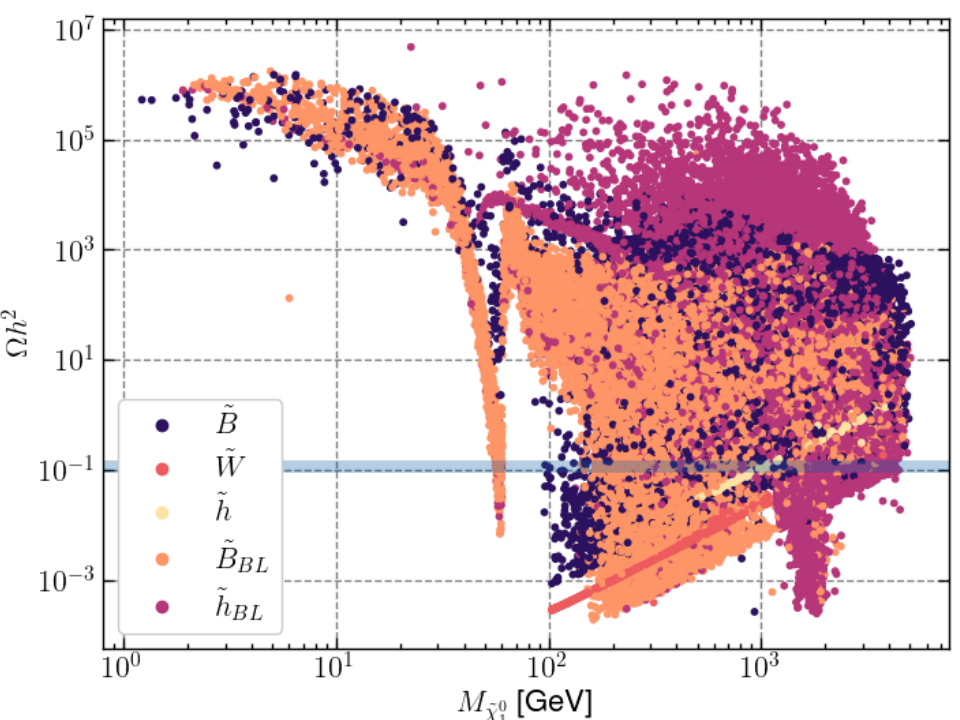
Figure 1: The relic density of the lightest neutralino as a function of its mass. The dominant component of the neutralino is colour coded as (cid:101) B (blue), (cid:102) W (red), (cid:101) h (yel- low), (cid:101) B (orange), and (cid:101) h (purple). The observed relic density of the Planck col- BL BL laboration [ 77 ] is shaded in blue including an uncertainty band of 0.03 to include computational / theoretical uncertainties. The model points shown here pass all con- straints of table